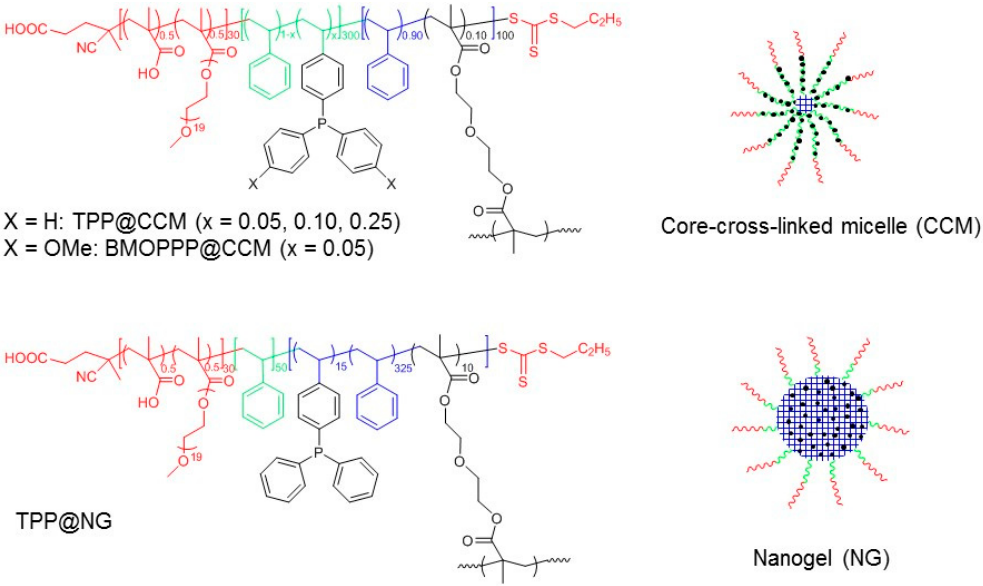
Figure 1. Catalytic nanoreactors previously made in our laboratory [7–10].